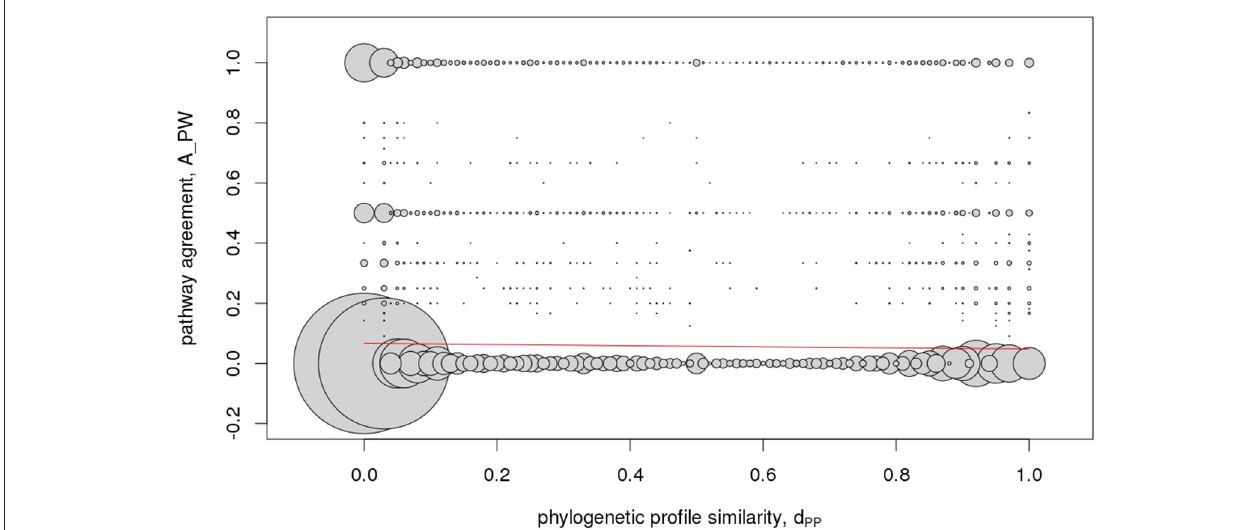
FIGURE 7 | Metabolic pathway - phylogenetic profile correlation statistic. Pairwise agreement of pathway memberships, A_PW, of gene objects (families and singletons) in relation to their respective phylogenetic profile similarity, d PP . Because the underlying data are discrete resulting in many identical value-pairs, their respective frequency is illustrated by the area of the circles centered on the observed value-pairs. The red line signifies the logistic fit (see section Materials and Methods) and suggests that pathway similarity cannot be inferred on the basis of similar phylogenetic profiles of gene pairs.